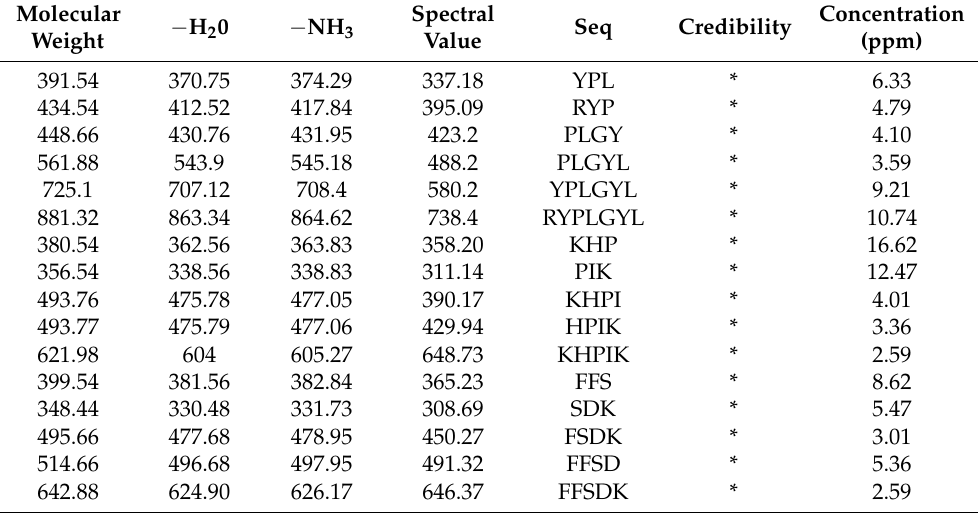
Table 4. KHPIK hydrolysis after mass spectrometry